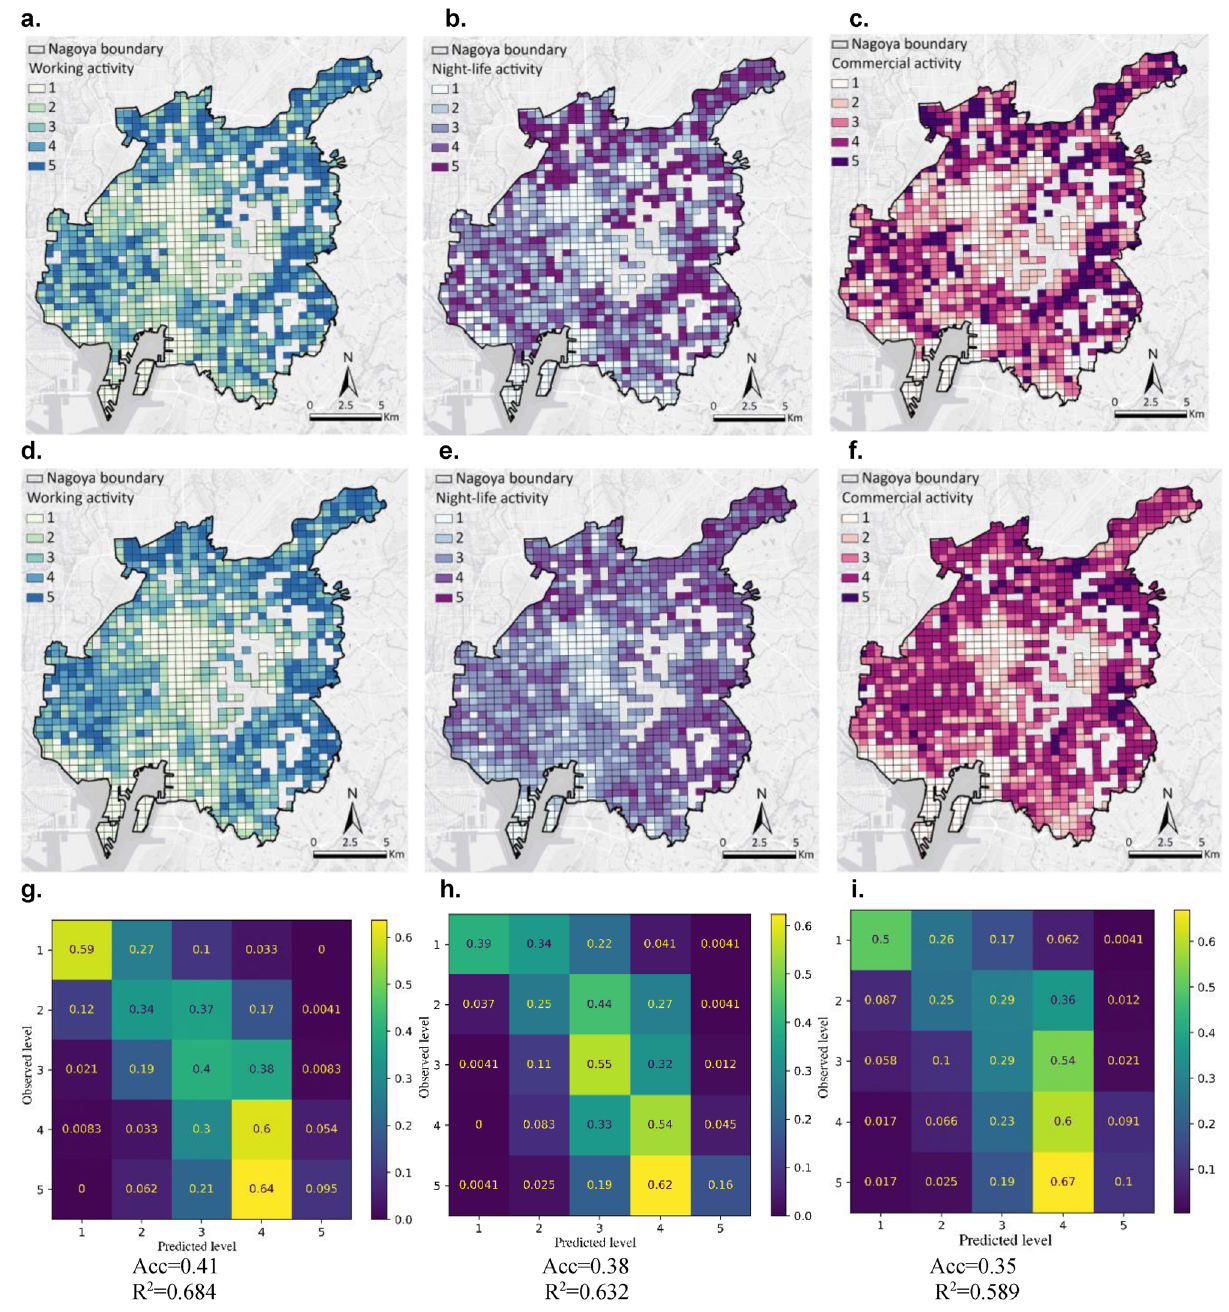
Figure 1. Observed and predicted urban recovery levels in Nagoya. ( a – c ) Observed urban recovery levels for working, night-life, and commercial activities, respectively; created using ArcGIS Pro Version 2.9 from ESRI (http:// www. arcgis. com/). ( d – f ) Predicted urban recovery levels for working, night-life, and commercial activities, respectively; created using ArcGIS Pro Version 2.9 from ESRI (http:// www. arcgis. com/). ( g – i ) Hit rates for working, night-life, and commercial activities, respectively; created by Anaconda Navigator Version 1.9.12 from Anaconda (https:// www. anaco nda.